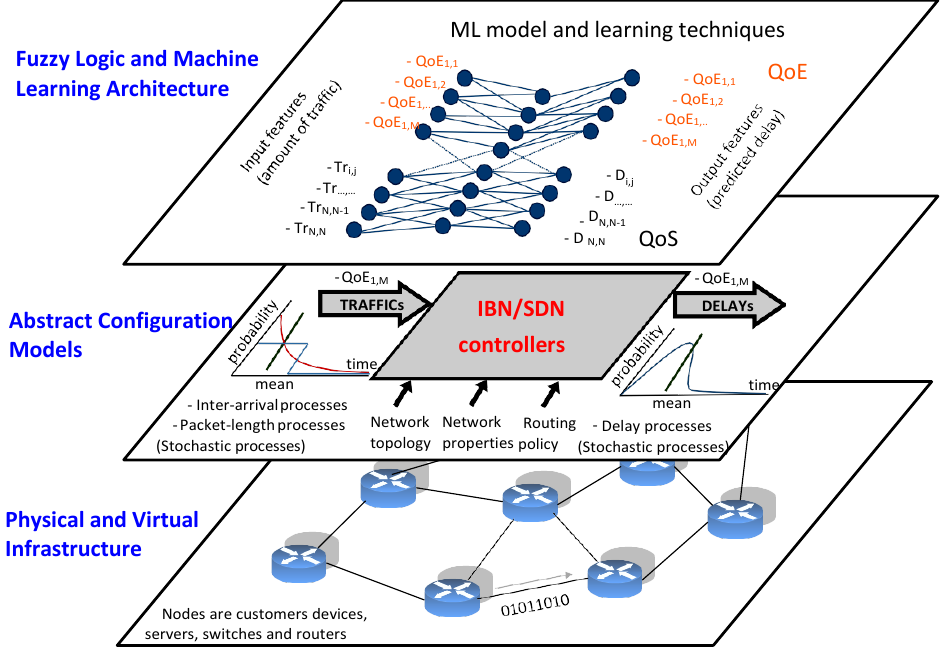
Figure 34. Applying fuzzy logic and machine learning techniques for the future IBN.